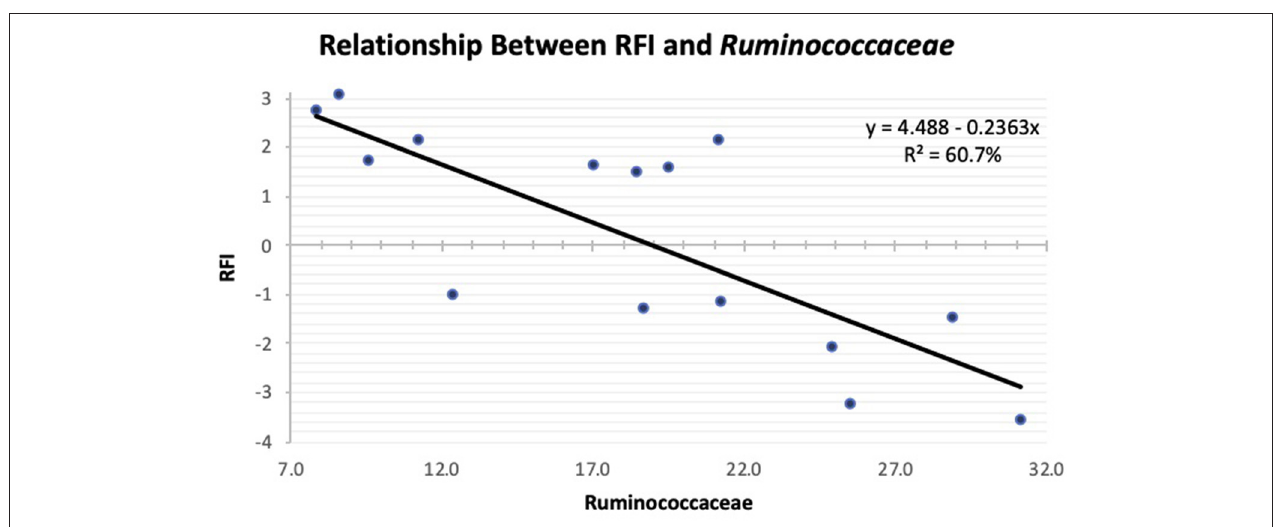
FIGURE 4 | Linear regression expressing the relationship between RFI and abundance of Ruminococcaceae in the feces of Angus steers at slaughter.